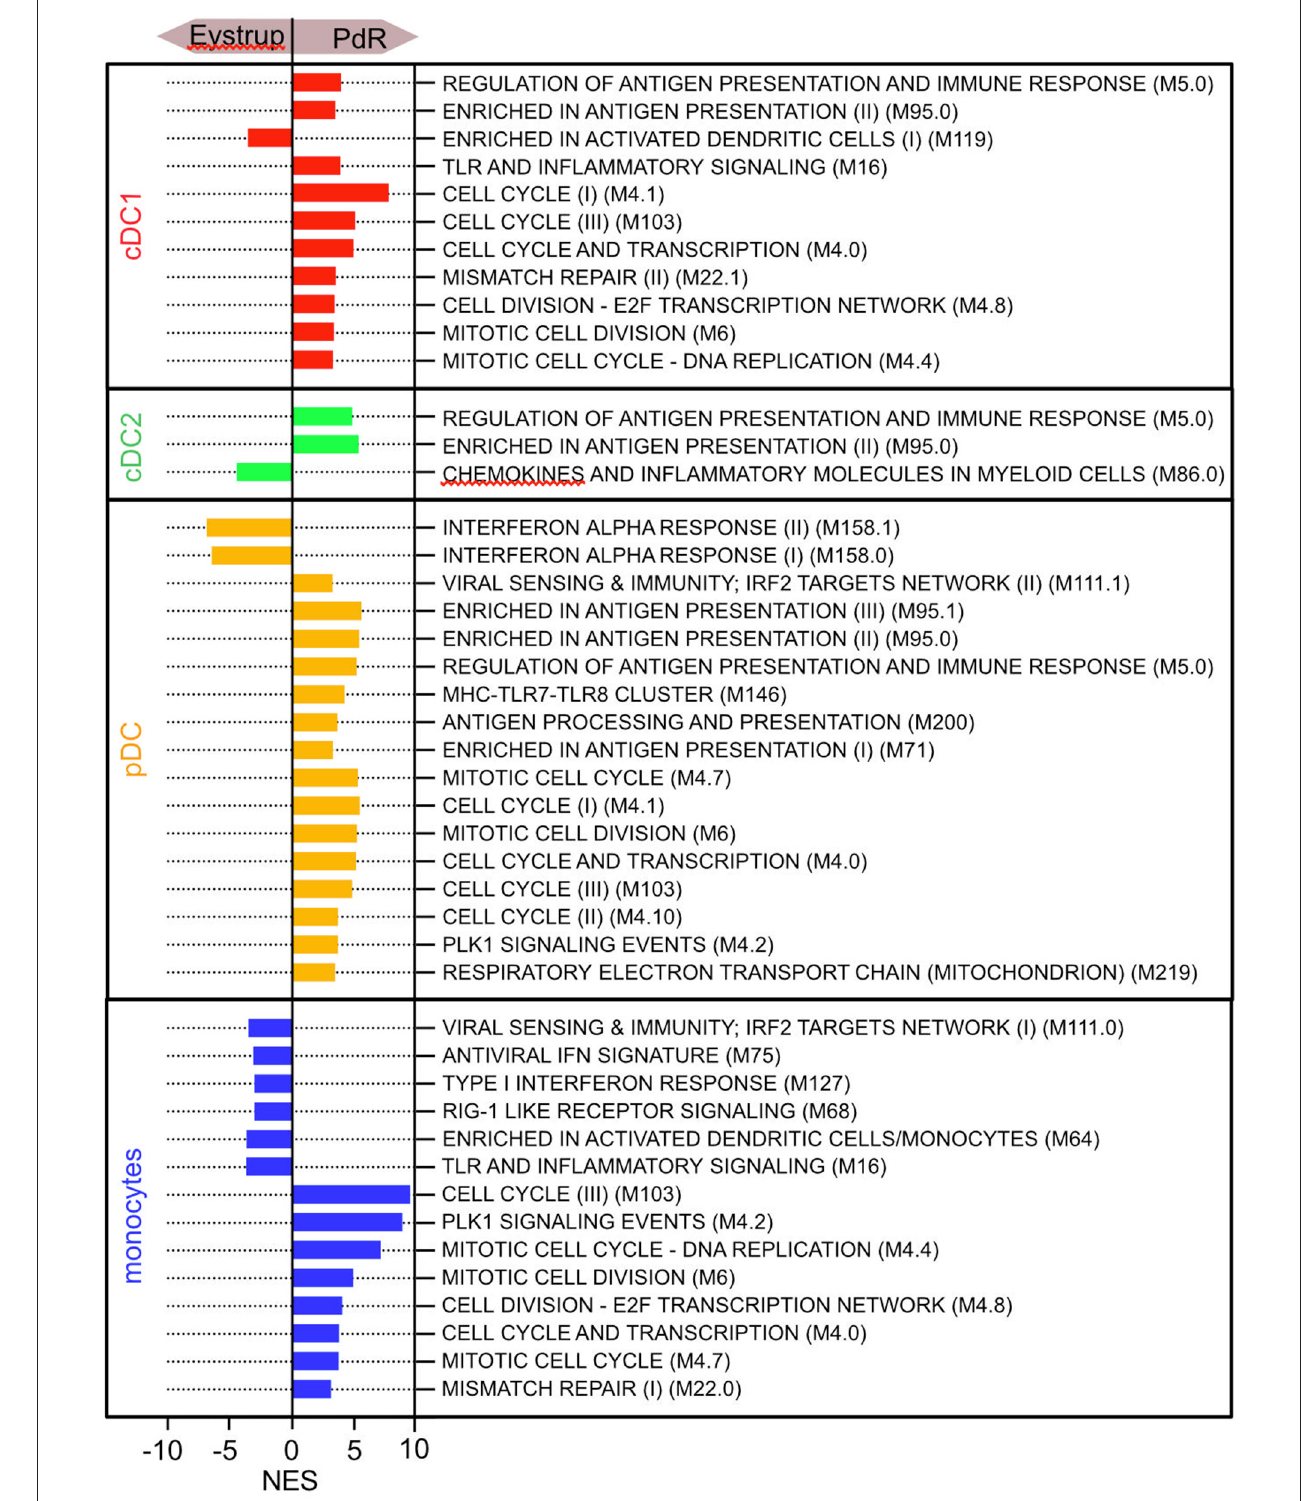
FIGURE 8 | Gene-set enrichment analysis of sorted DC and monocytic cells from lymph nodes using 86 selected gene sets that were derived from the BTM described by Li et al. (25). The normalized enrichment scores (NES) for all modules with a FDR < 0.05 are shown.